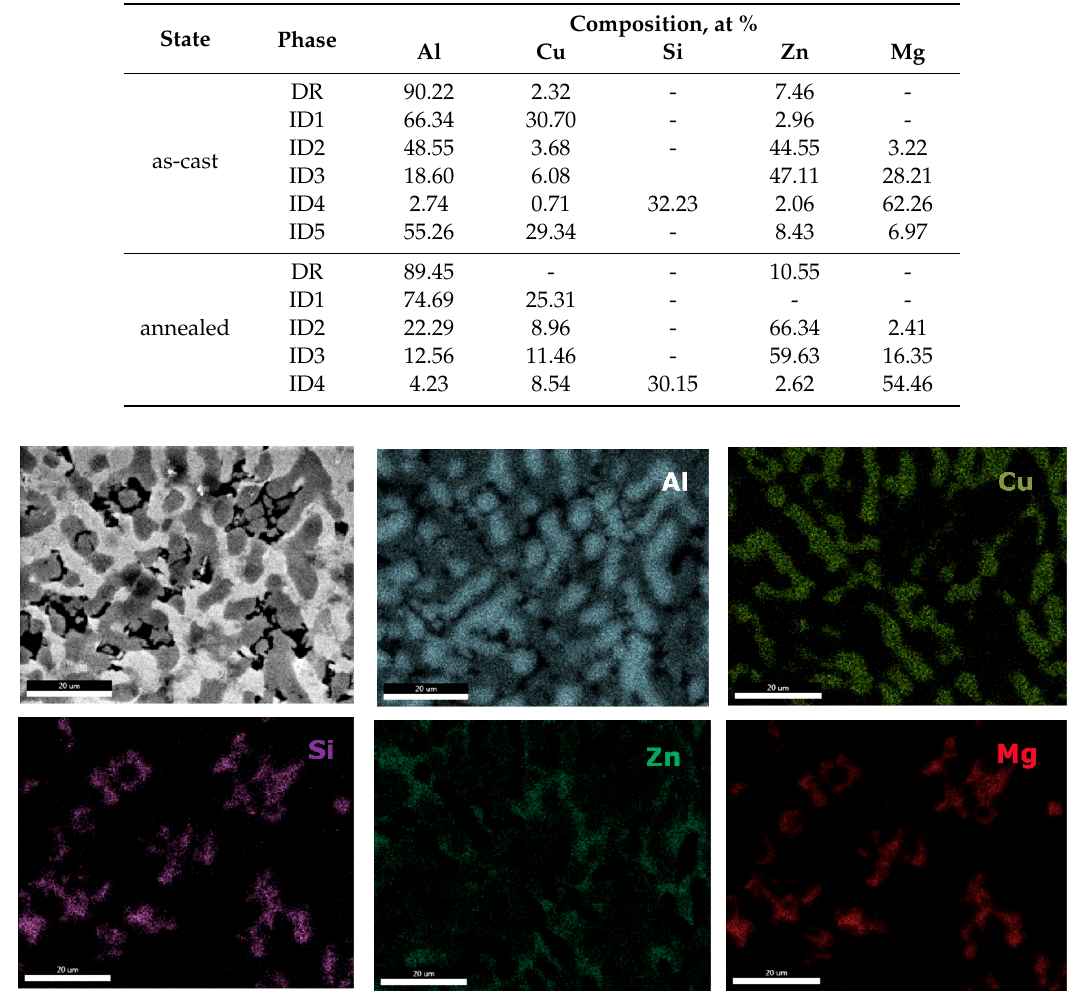
Figure 17. EDS mapping of heat treated Al 3.4 Cu 0.5 Si 0.2 Zn 0.5 Mg 0.2 alloy.